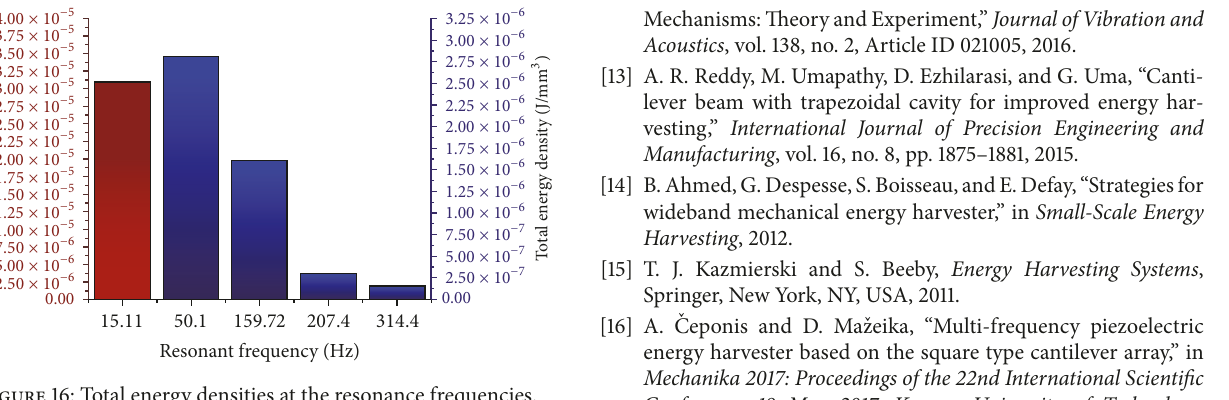
Figure 16: Total energy densities at the resonance